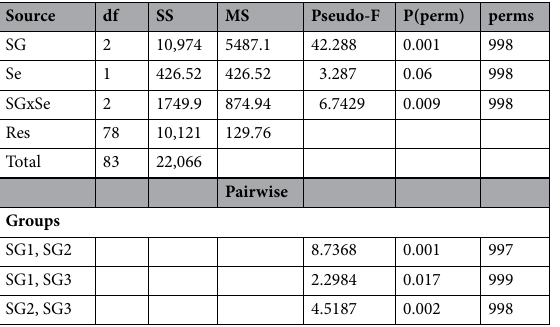
Table 2. PERMANOVA result showing the significant differences in physicochemical variables among the three site groups in the Niger Delta Region Streams during the study period (2008–2012). SG site group, Se season, Res